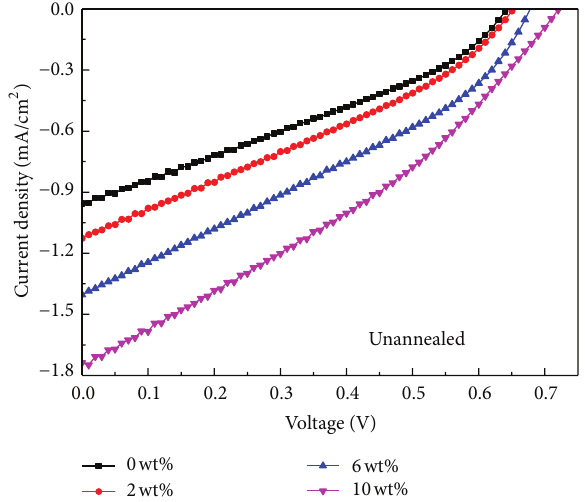
Figure 6: Current density versus voltage curves of PSCs with dif- ferent Ir(btpy) 3 doping concentrations under illumination intensity 100mW/cm 2